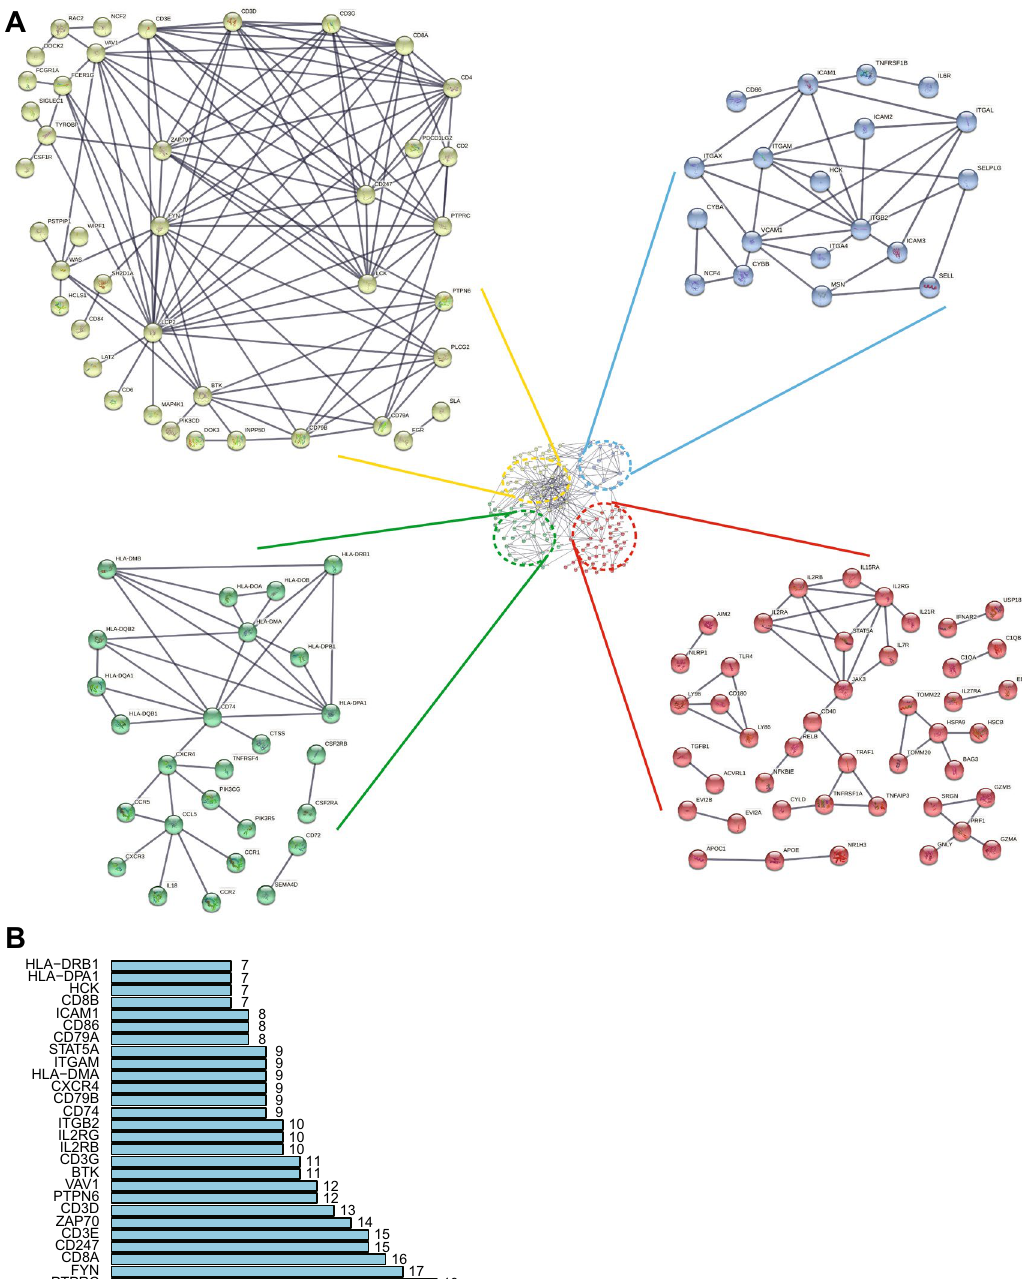
Figure 7. The results of protein–protein interactions of differentially expressed genes co-existing in the training cohort and validation cohort. A total of 322 differentially expressed genes were analyzed in the STRING database, a network ( A ) of PPIs was acquired (the confidence was 0.95), the different colors represented different subgroups after PPI analysis, and the top 30 genes ( B ) were ranked by interaction